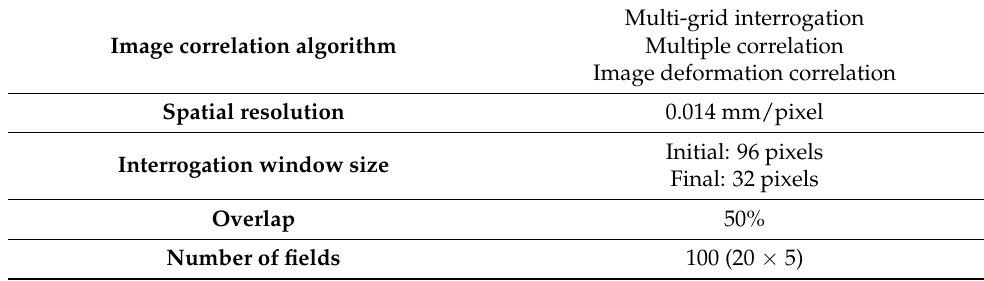
Figure 4. PIV system. Table 1. Conditions of the velocity field calculation.